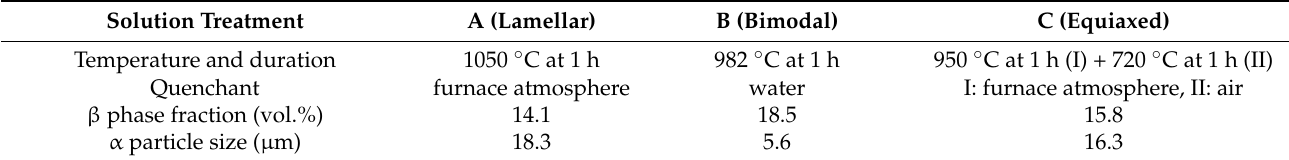
Table 1. Parameter for solution annealing and resulting microstructural parameters.